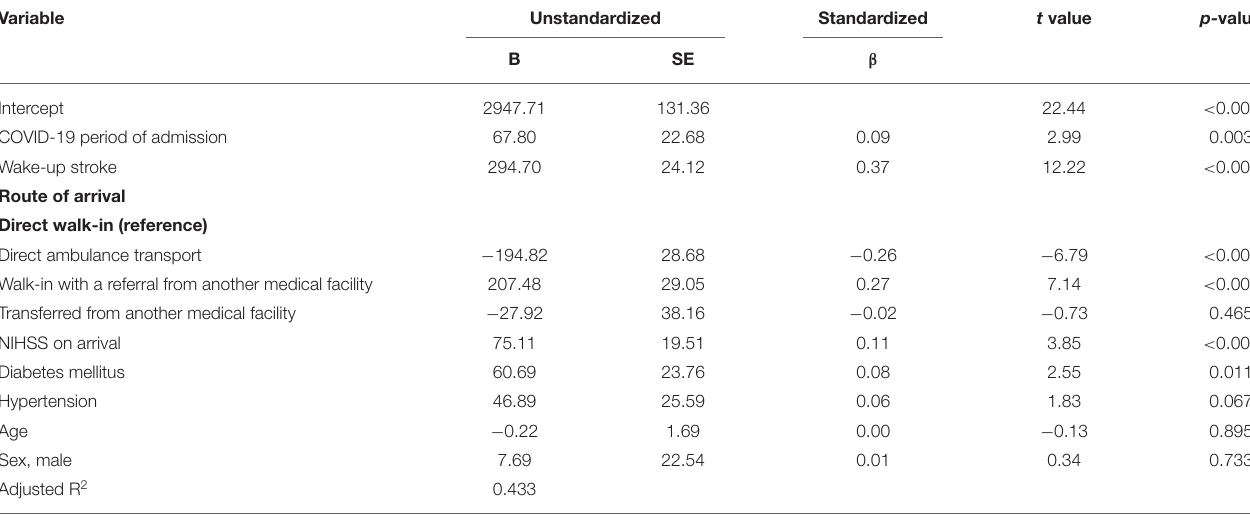
TABLE 2 | Multivariable regression analyses for the factors associated with onset-to-door time.